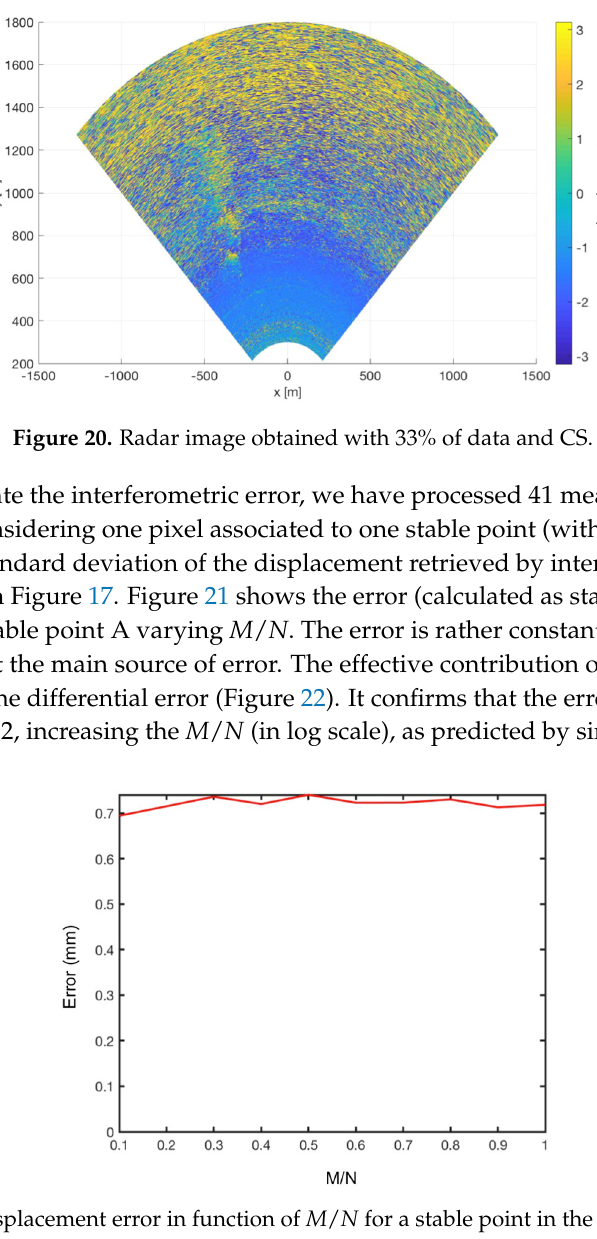
Figure 19. Radar image obtained with 50% of data and CS.